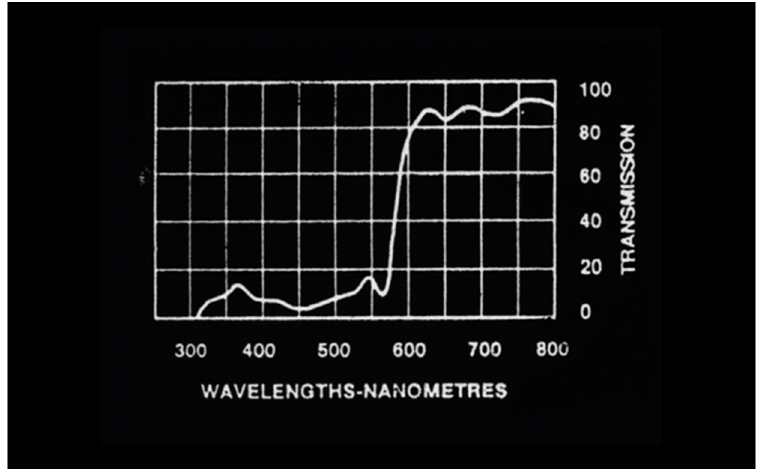
Figure 3. 025 Sunset Red